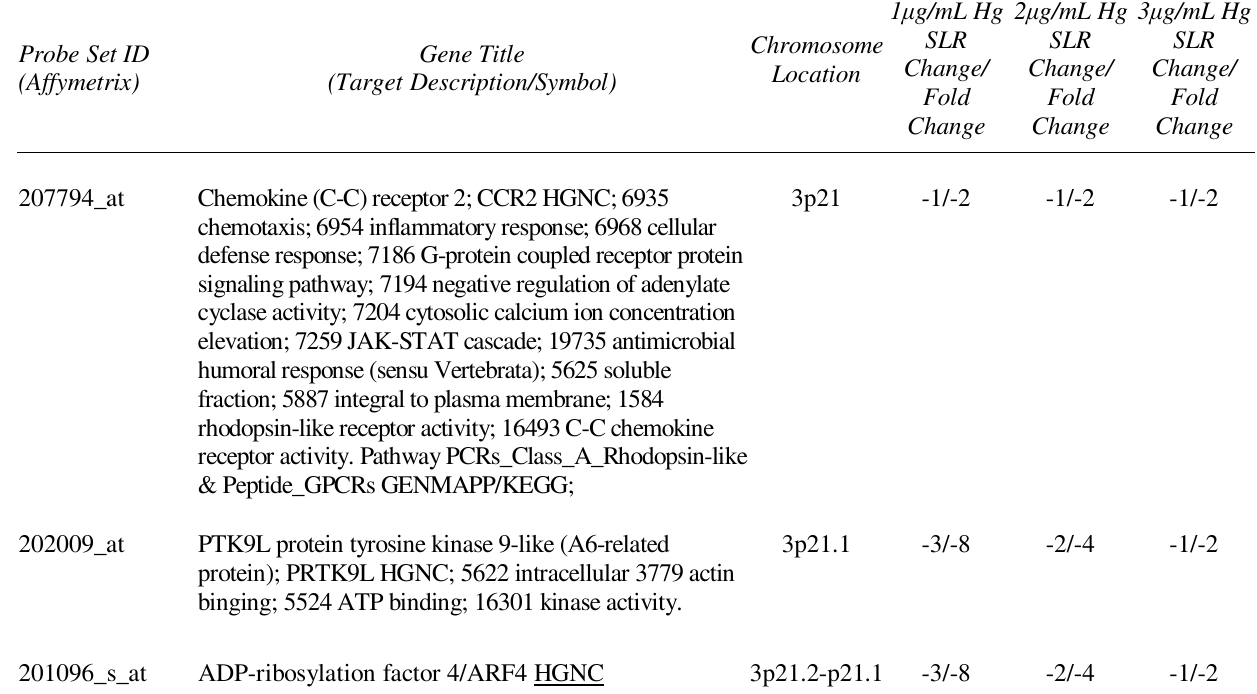
Table 1 contd.: Sample genes affected by mercury. Probe Set